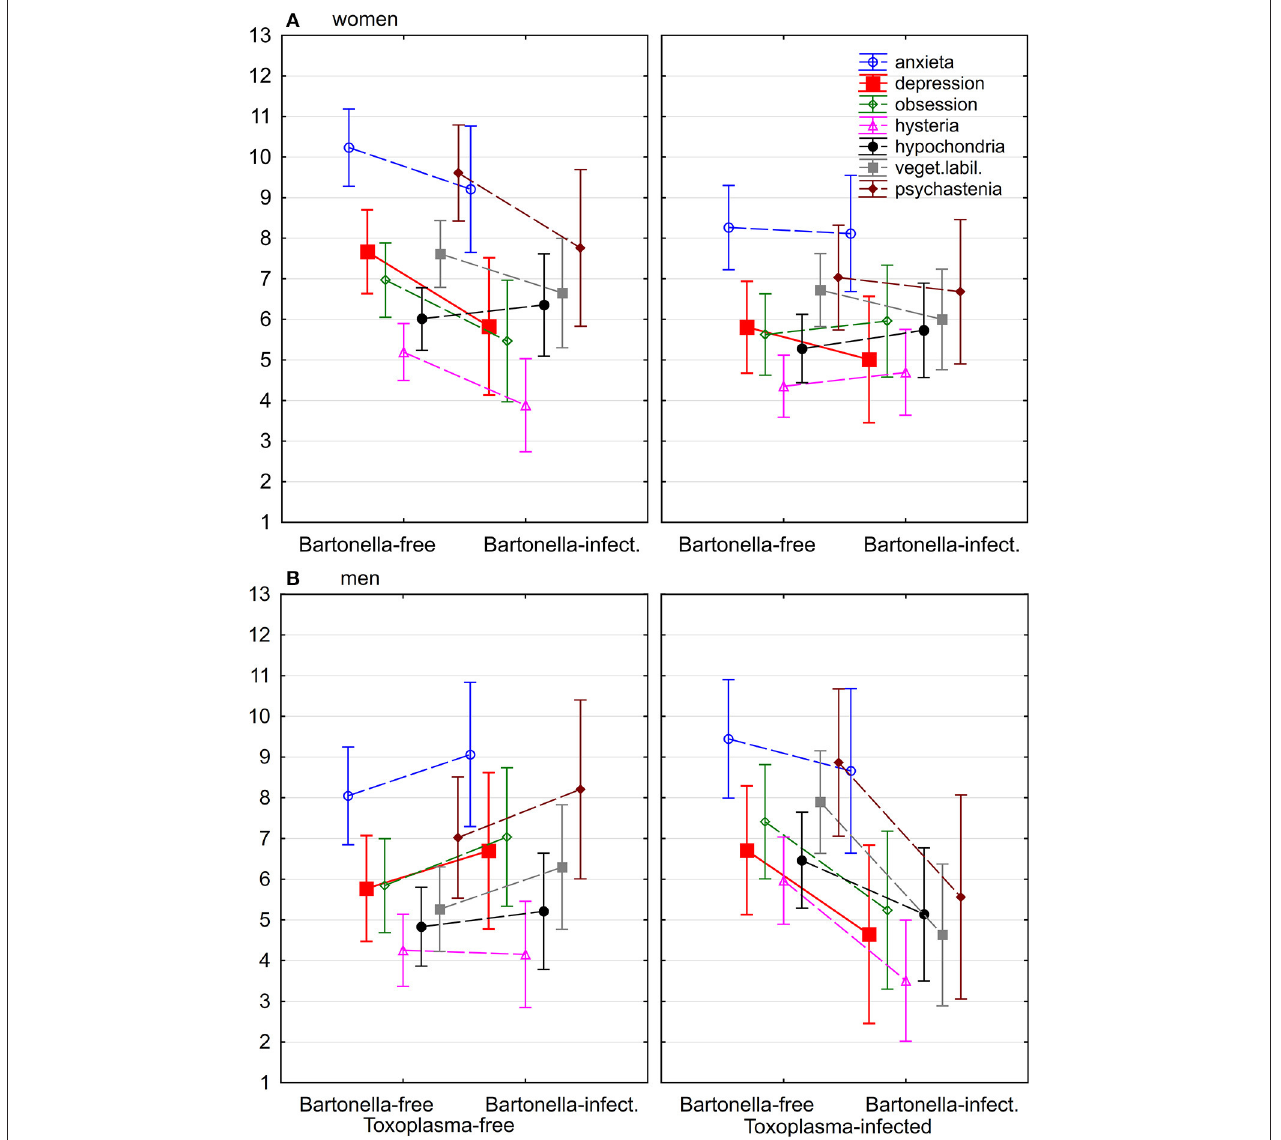
FIGURE 1 | Association of Bartonella and Toxoplasma seropositivity with seven neuroticism subscales of N-70 in women (A) and men (B) . Markers show the intensity of health problems computed for covariates at their means.